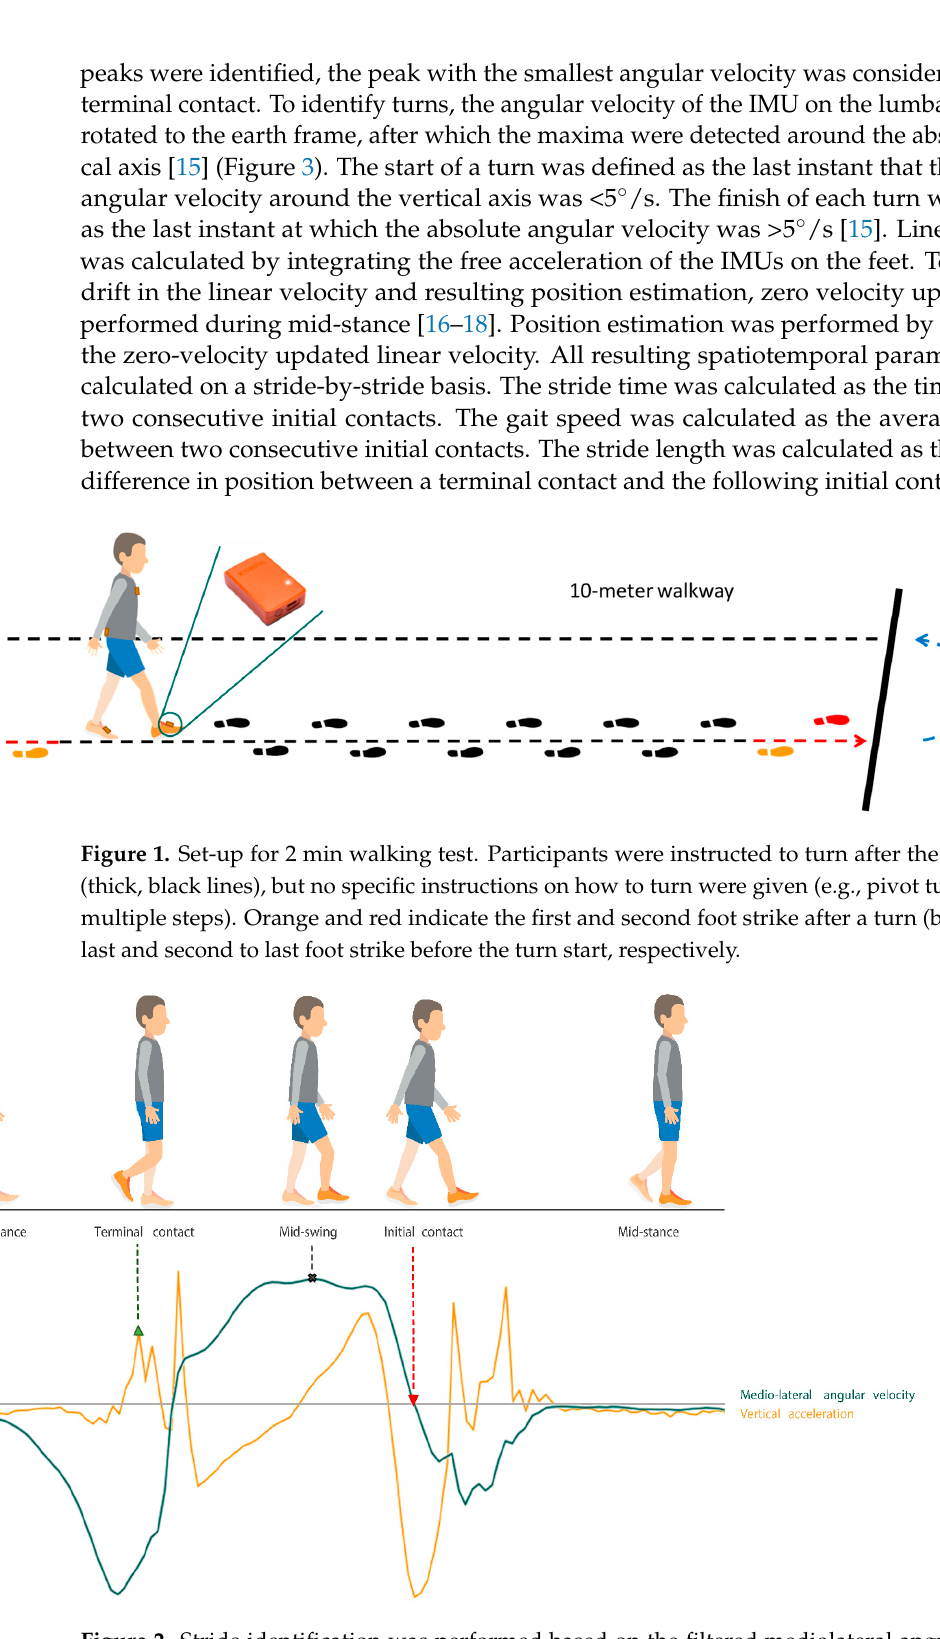
Figure 3. Turns (grey areas) were identified at the local maxima of the absolute angular velocity (rotated to the earth frame) around the vertical axis (green z-axis) of the lumbar sensor (top graph) [11]. The start of a turn was defined as the last instant that the absolute angular velocity around the vertical axis was <5°/s. The finish of each turn was defined as the last instant at which the absolute angular velocity was >5°/s [11].